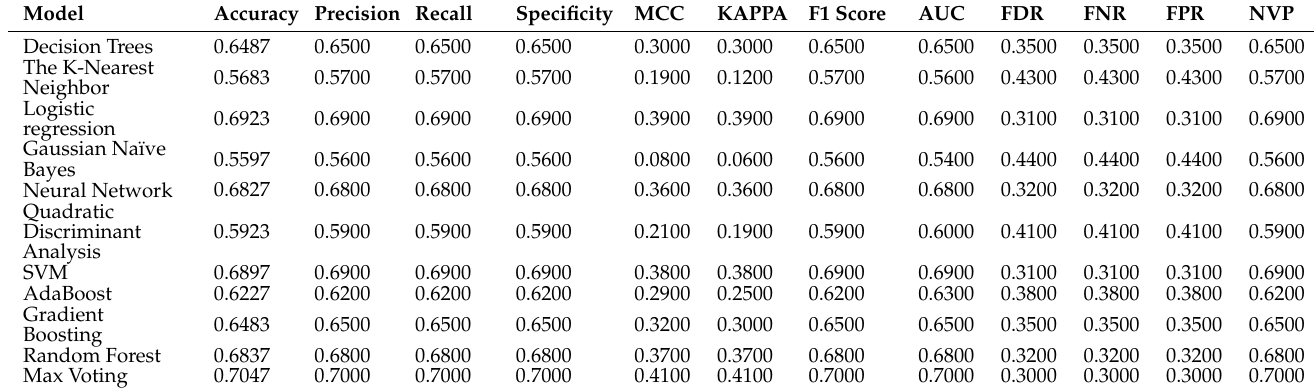
Table 4. Result of Dataset 1 using the Machine Learning Algorithms and Ensemble learning methods.